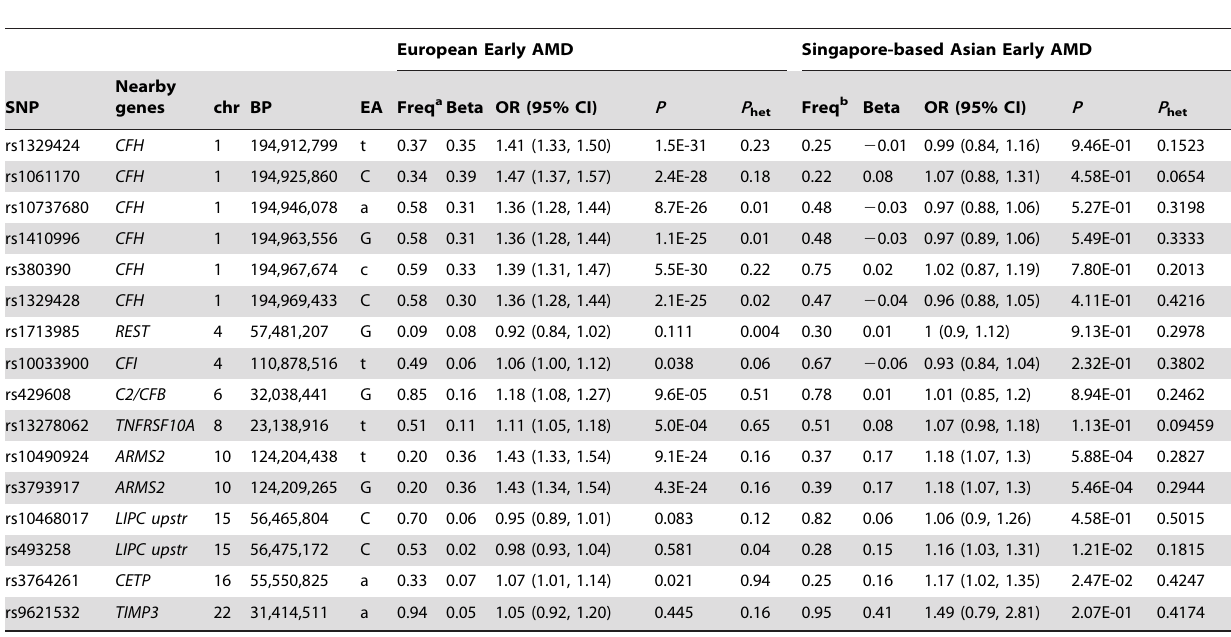
Table 5. Tabulation of estimated effect sizes for European-ancestry versus Asian ancestry analyses of early AMD, for the validated AMD-associated SNPs shown in Table